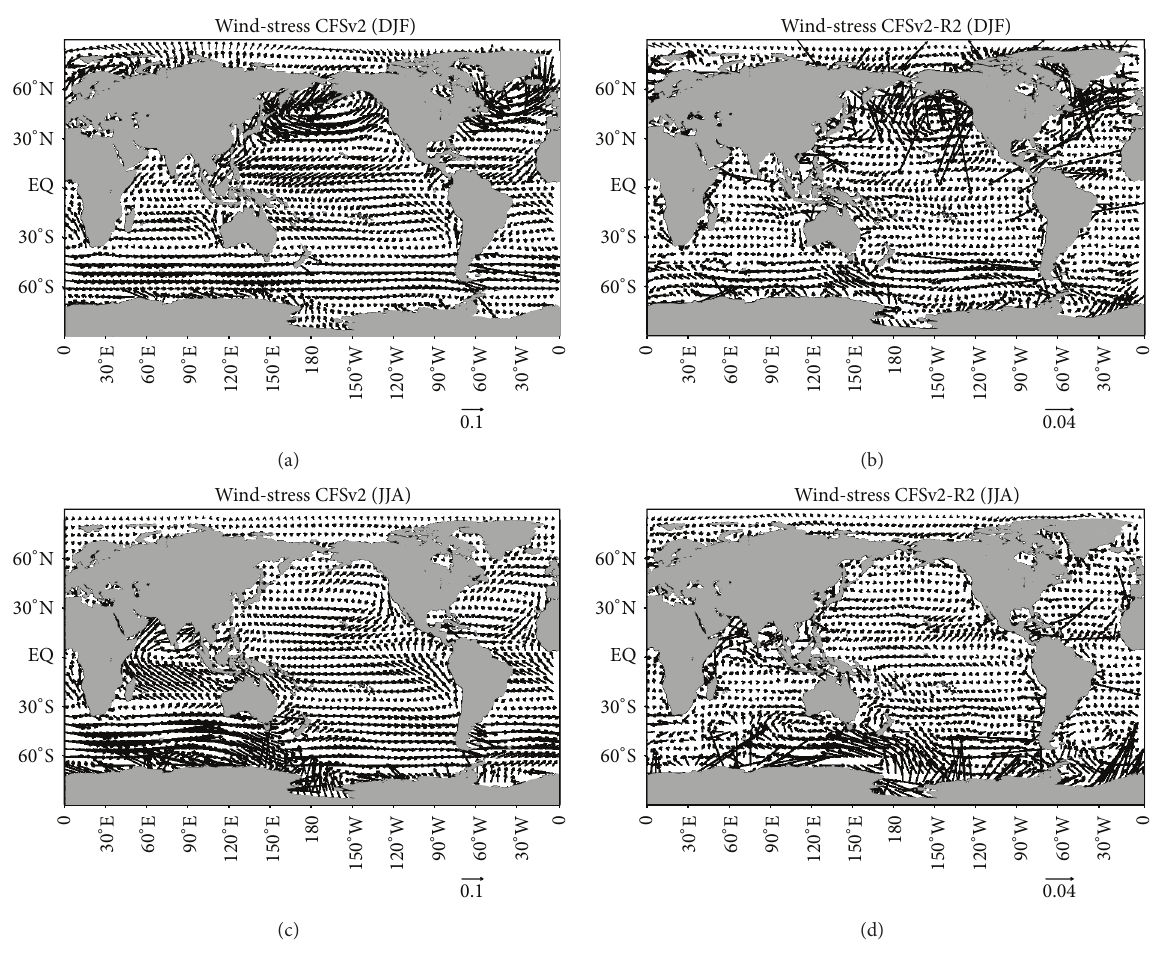
Figure 6: As in Figure 5, but for mean wind-stress vectors. The reference vector corresponds to 0.1 N/m 2 ((a) and (c)) and 0.04 N/m 2 ((b) and